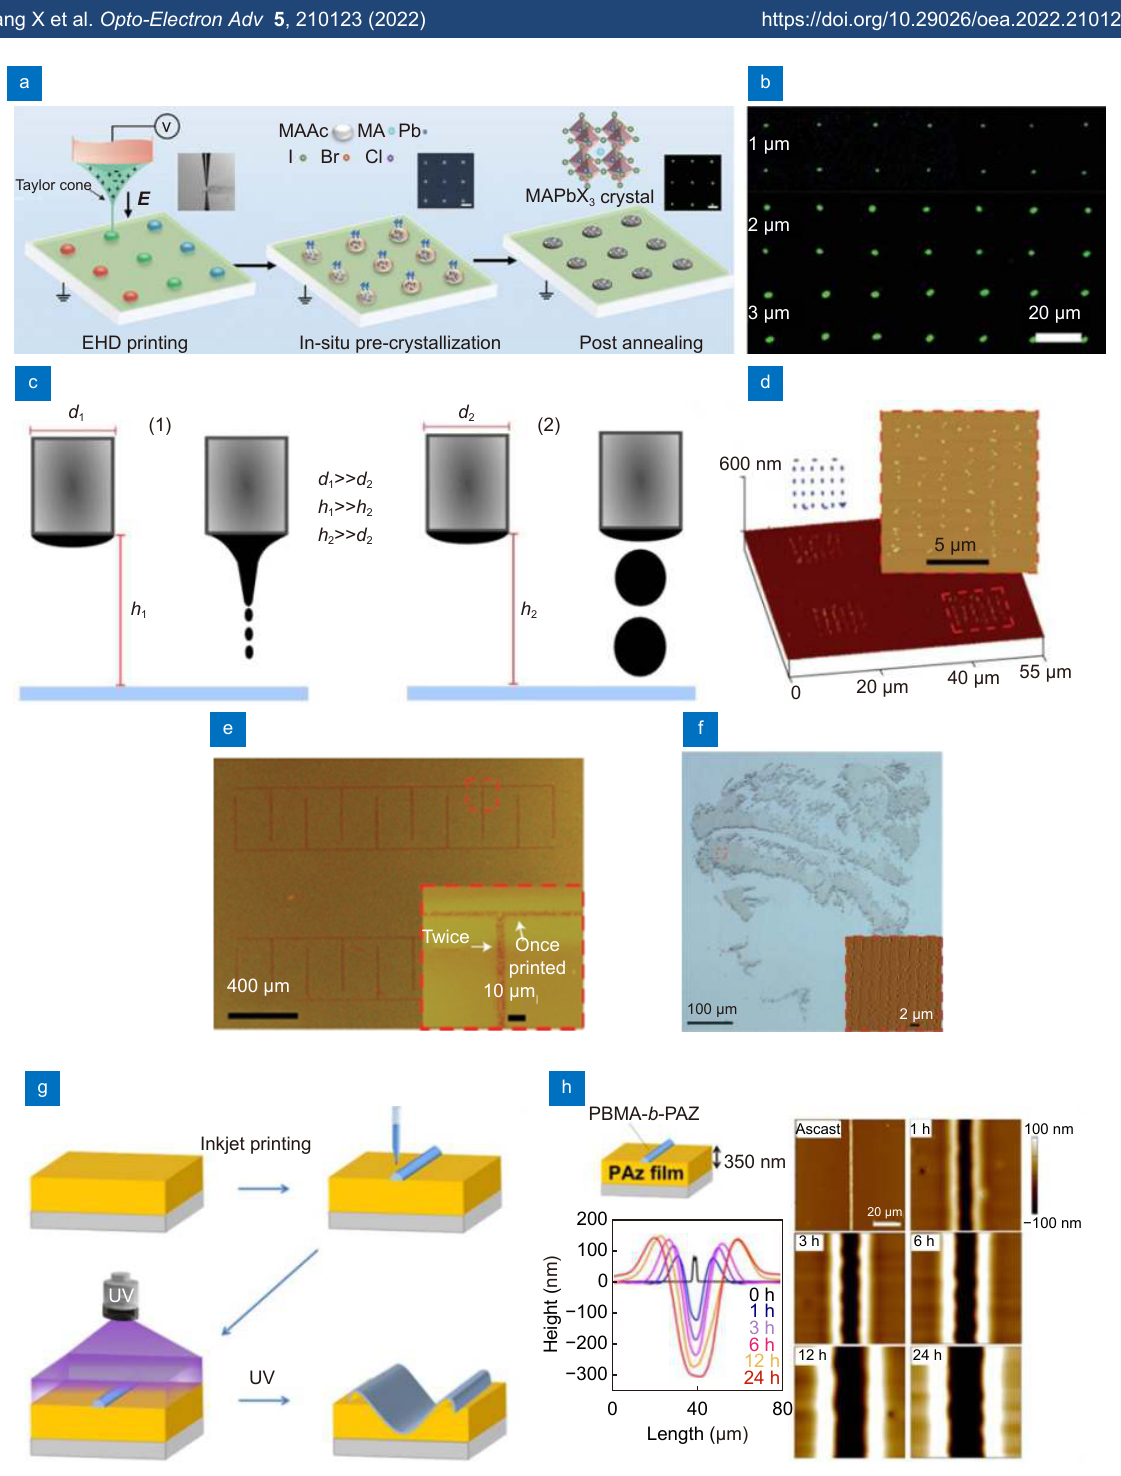
Fig. 11 | ( a ) Schematic illustration of the EHD inkjet printing fabrication process and perovskite transformation. ( b ) The EHD printed high-resolu- tion dot array with dot diameters of 1, 2, and 3 μm respectively. ( c ) Printing mode of conventional EHD inkjet printing (1) vs SIJ (2) shown with and without ink charging. ( d ) Three-dimensional AFM image of aligned arrays of dots. ( e ) Continuous lines printed using the single-walled